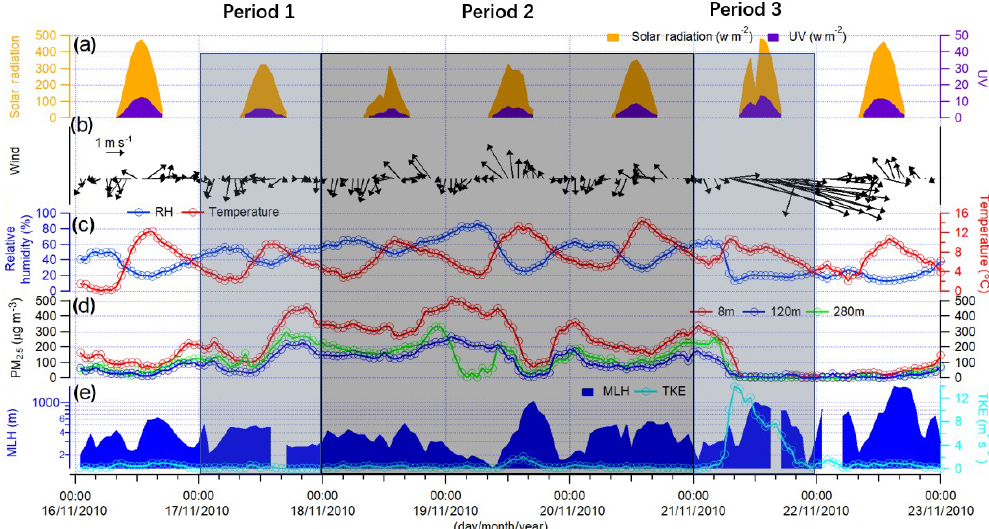
Figure 1. Measurements of (a) solar radiation and ultraviolet radiation at 8m, (b) wind speed and direction at 8m, (c) relative humidity and air temperature at 8m, (d) mass concentration of PM 2 . 5 at 8, 120 and 280m, and (e) mixing layer height at 8m and turbulence kinetic energy at 140m in the Beijing 325m meteorology tower during an intensive air pollution episode in November 2010. The evolution of the air pollution episode can be divided into period 1 (clean period to air pollution accumulation period), period 2 (pollution period) and period 3 (pollution to clean period).